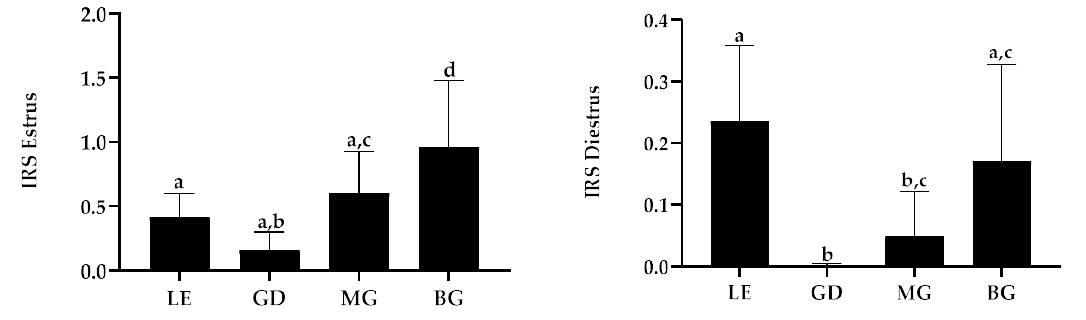
Figure 6. Myeloperoxidase immunoreactive score (IRS) in estrus and diestrus for each cell popula- tion. Data are displayed as raw data (mean with SD). Columns with a different superscript are sta- tistically different ( p < 0.05). LE: luminal epithelium; GD: glandular ducts; MG: mid glands; BG: basal glands.